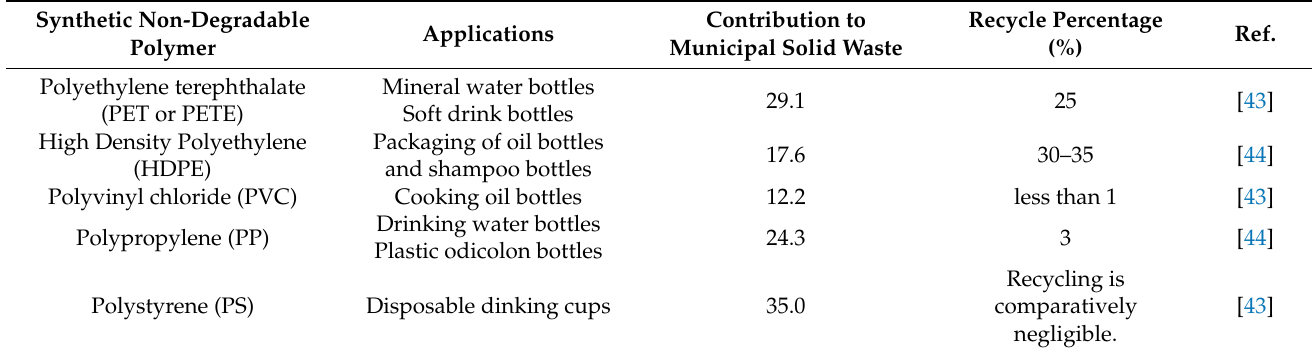
Table 1. Different types of synthetic polymers and their contribution to solid